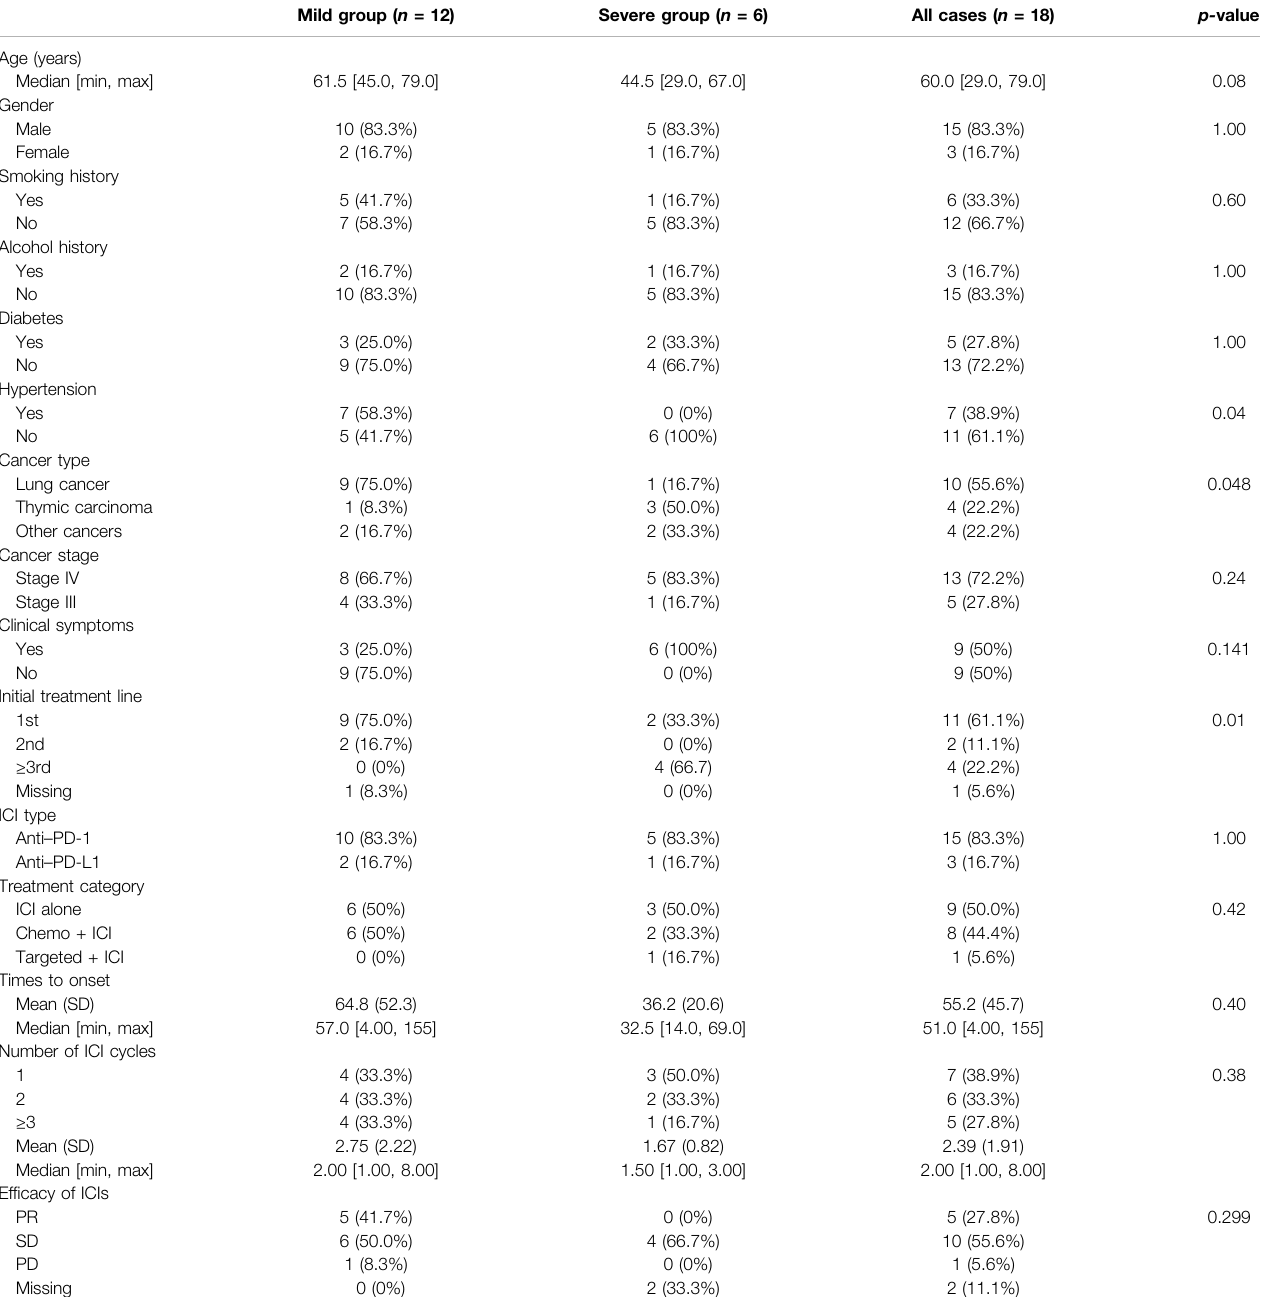
TABLE 1 | Clinical characteristics of the patients and information on ICI in patients with immune-related myocarditis. Mild group ( n = 12) Severe group ( n =